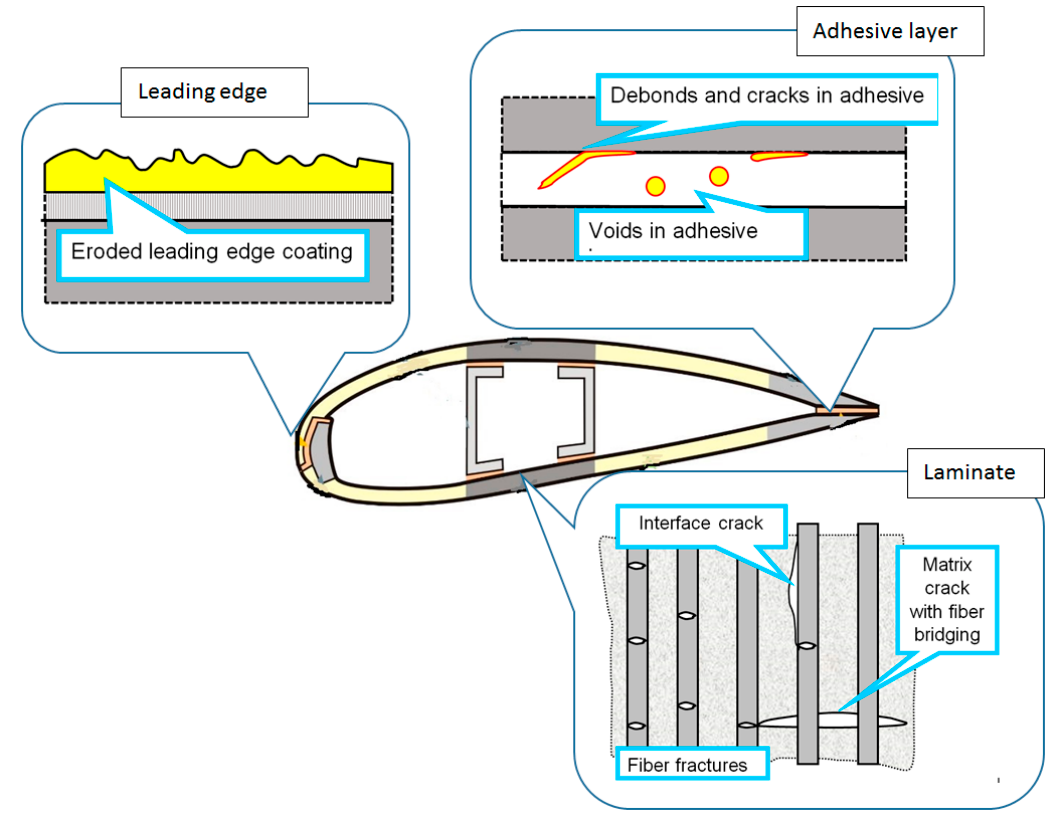
Figure 2. Main structural damage mechanisms of wind turbine blades.